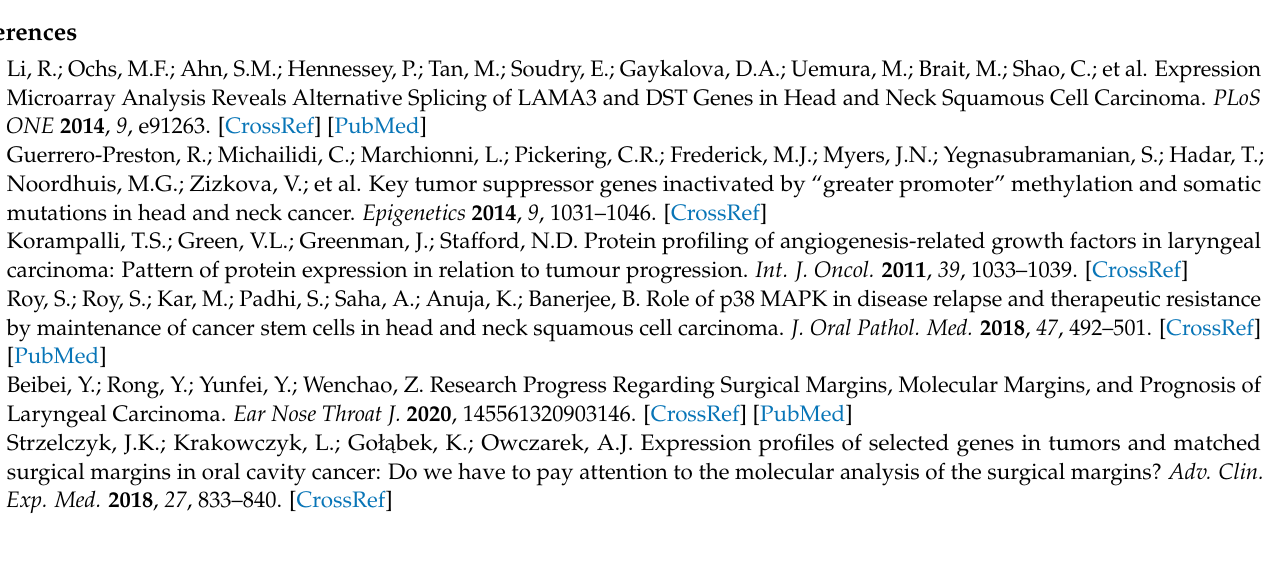
Table S3: Common processes for both tools, Table S4: Differentially expressed genes, surgical margin samples vs. HTEpiC, HBpiC and